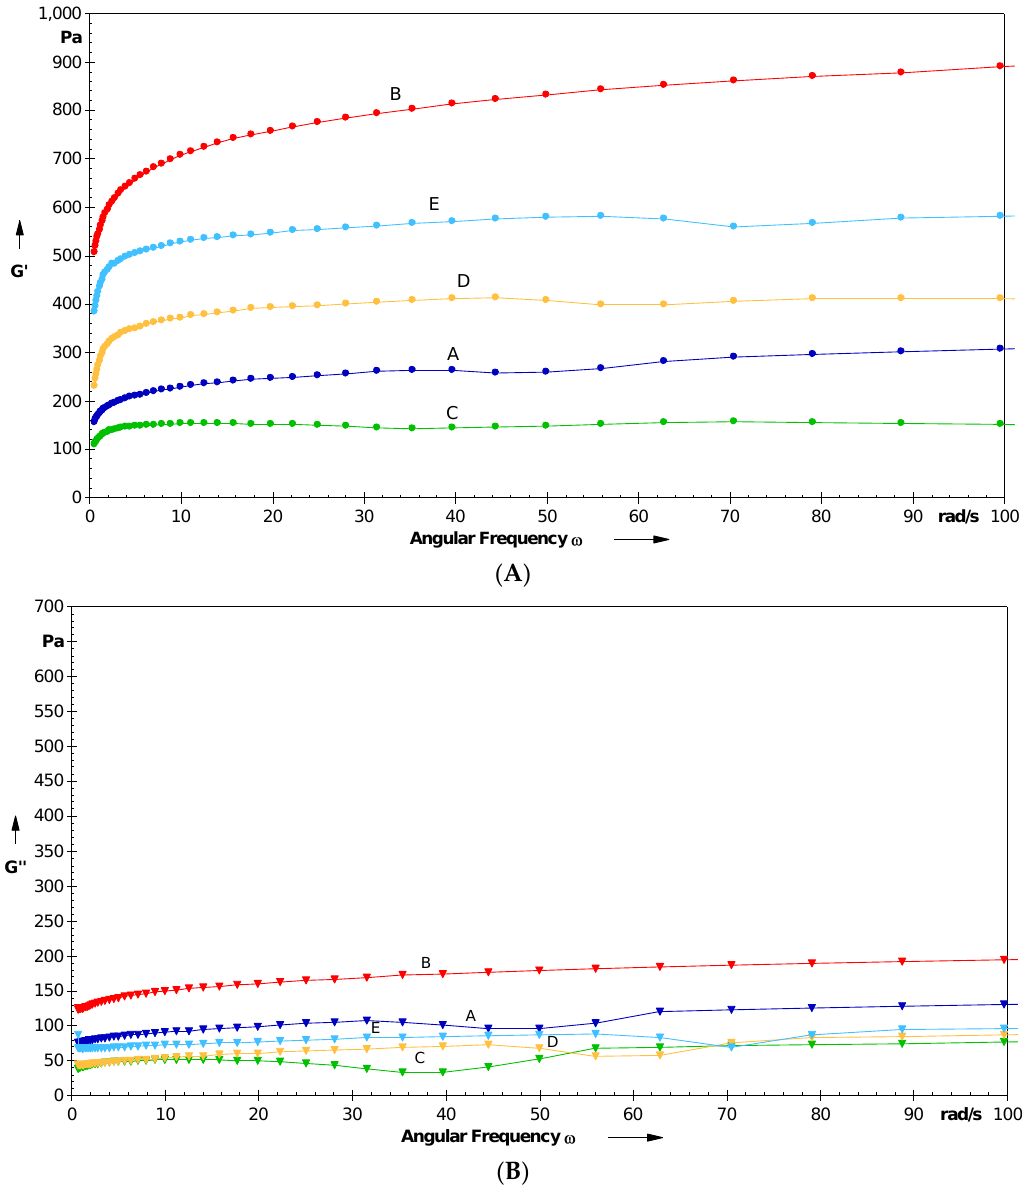
Figure 6. ( A ) Angular frequency dependence of G′ at 25 °C for native and modified lotus rhizome starches A — Native; B — MI; C — IR; D — MI-IR; E — IR-MI. ( B ) Angular frequency dependence of G ″ at 25 °C for native and modified lotus rhizome starches A — Native; B — MI; C — IR; D — MI-IR; E — IR-MI.